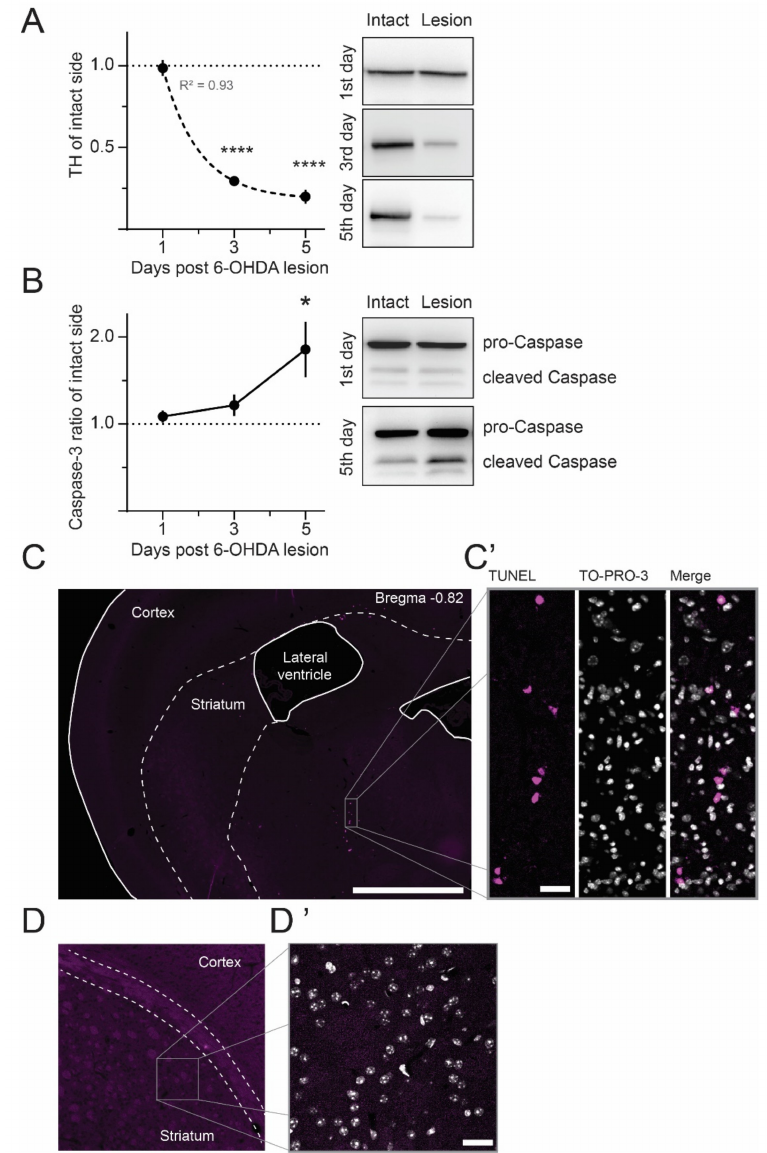
Figure 2. The peak of caspase-3 activation follows the loss of striatal DAergic innervation. ( A ) Western blot analysis of striatal TH levels shows an exponential decline of DAergic innervation between one and five days after the 6-OHDA lesion (dotted line depicts a one-phase decay fit with the given R 2 value). **** p < 0.0001 vs. one day post-lesion, ANOVA and post hoc Bonferroni test, N = 6–7. Right: Representative immunoblots with TH bands (60 kDa). ( B ) Caspase-3 activation was assessed as a ratio of the cleaved (19 and 17 kDa bands) over the uncleaved protein (35 kDa). The ratios are shown relative to the corresponding intact striatum and confirm a peak of caspase-3 activation at five days post-lesion. * p < 0.05 vs. one day post-lesion, ANOVA and post hoc Bonferroni test, N = 6–7. Right: Example of caspase-3-stained blots. ( C , D ) TUNEL staining was used to reveal apoptotic nuclei in sections through the caudal diencephalon (encompassing the MFB, C ) and DA-denervated striatum ( D ). At the peak of caspase activation (five days post-6-OHDA lesion), no TUNEL positivity was found in the striatum ( D , D’ ), whereas numerous cells displayed apoptotic features along the track of the 6-OHDA infusion ( C , C’ ). ( C’ , D’ ) High magnification of ( C , D ), as indicated. TUNEL (magenta) is overlaid with TO-PRO-3 counterstain of neuronal nuclei (gray). Among the TUNEL-positive cells, some are colabeled with TO-PRO-3 and others are not, indicating different stages of apoptosis. Scale bars: 1 mm ( C ), 40 µ m ( C’ ) 10 µ m ( D